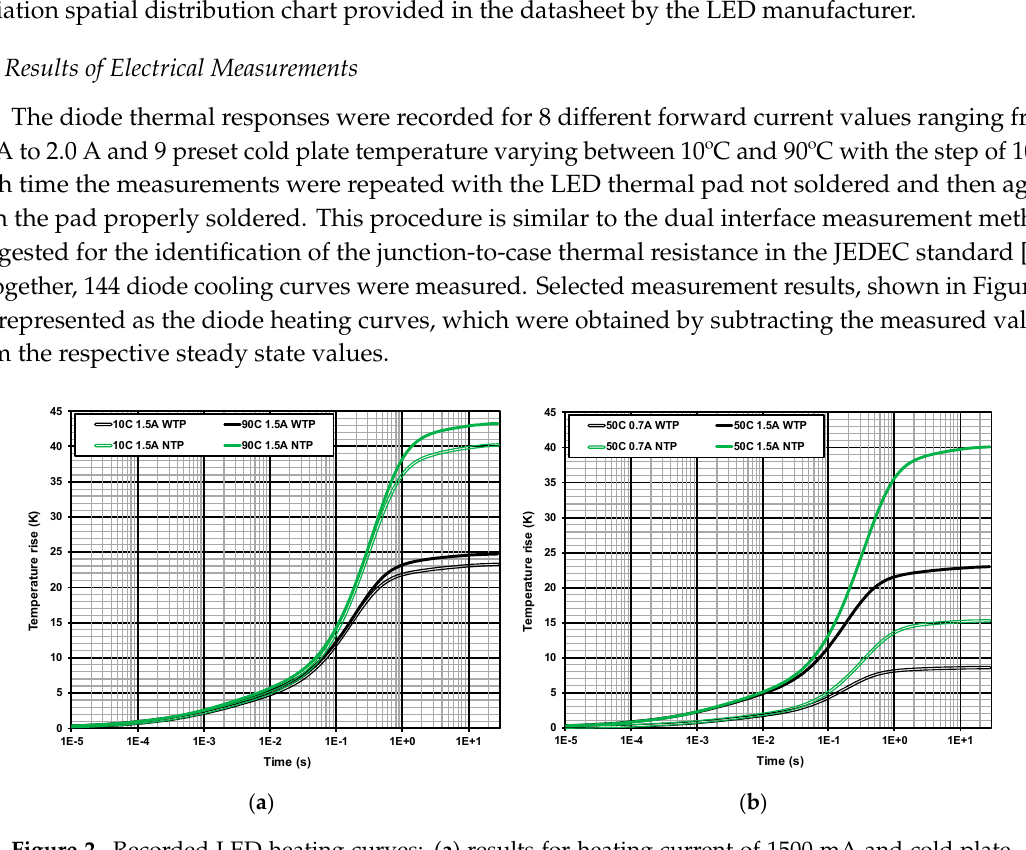
Figure 2. Recorded LED heating curves: ( a ) results for heating current of 1500 mA and cold plate temperature values 10°C and 90°C; ( b ) results for heating currents of 700 mA and1500 mA for cold plate temperature 50°C.